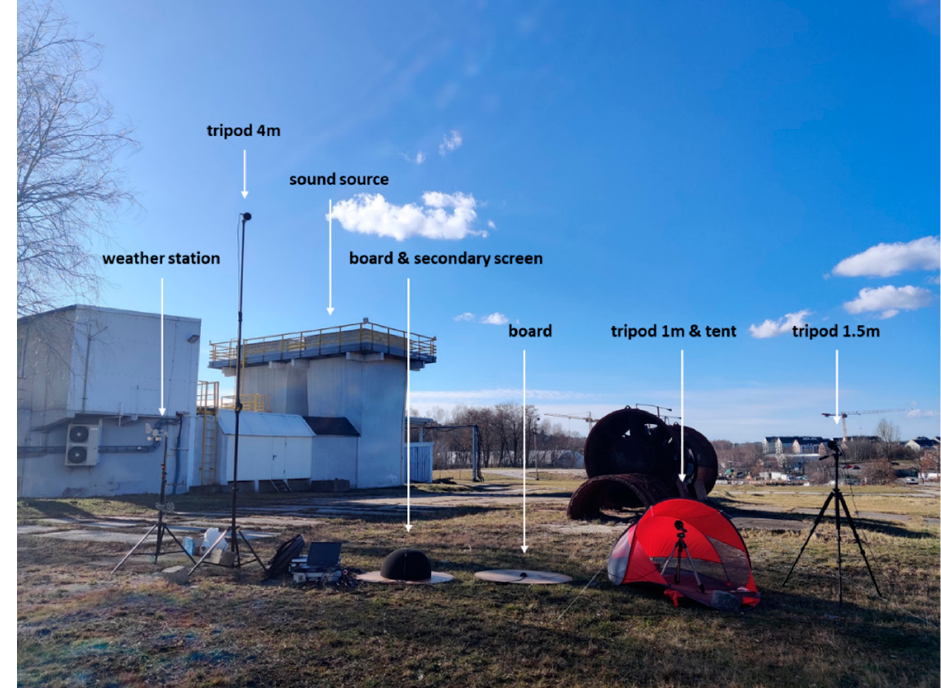
Figure 4. Placement of measuring microphones—general view.